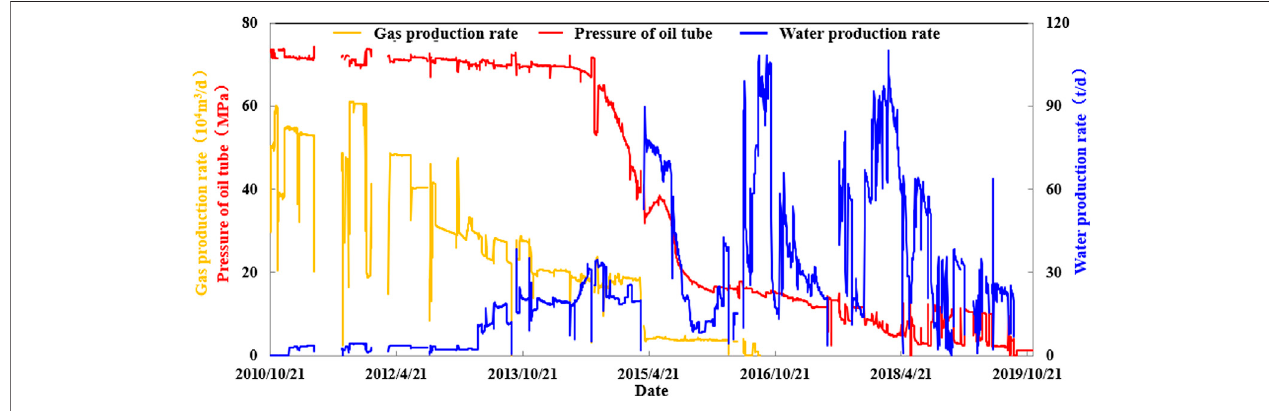
FIGURE 4 | Fracture characteristics of ultra-deep reservoirs in the Keshen gas fi eld.